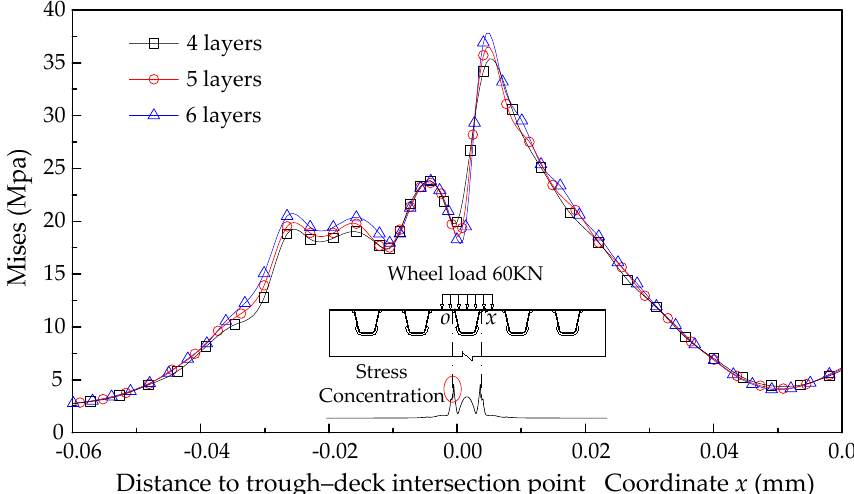
Figure 5. Mesh sensitivity check of the local model.